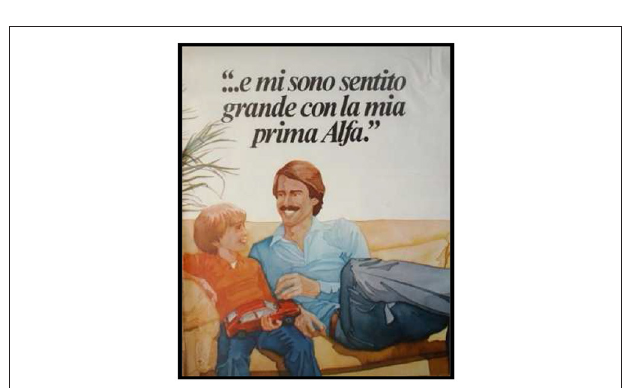
FIGURE 3 | “… and I felt grown up with my first Alfa.”